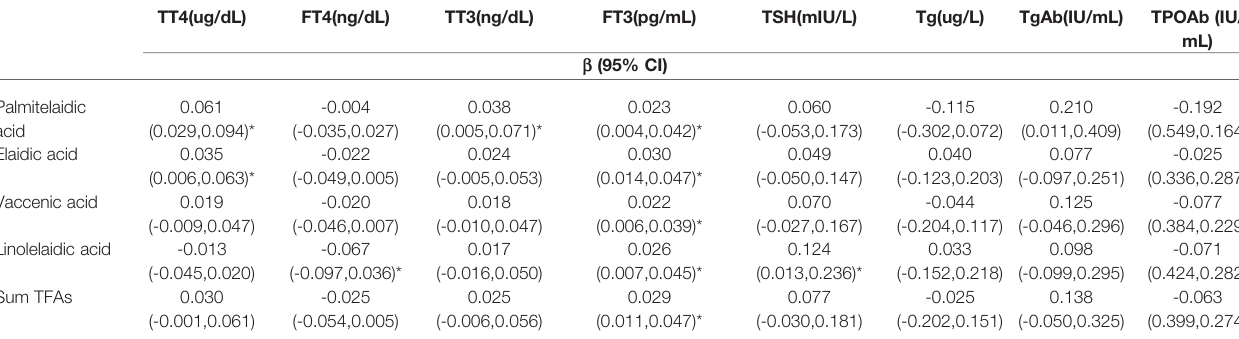
TABLE 3 | Multivariate regression analyses of log-transformed serum TFAs in relation to log-transformed serum thyroid function